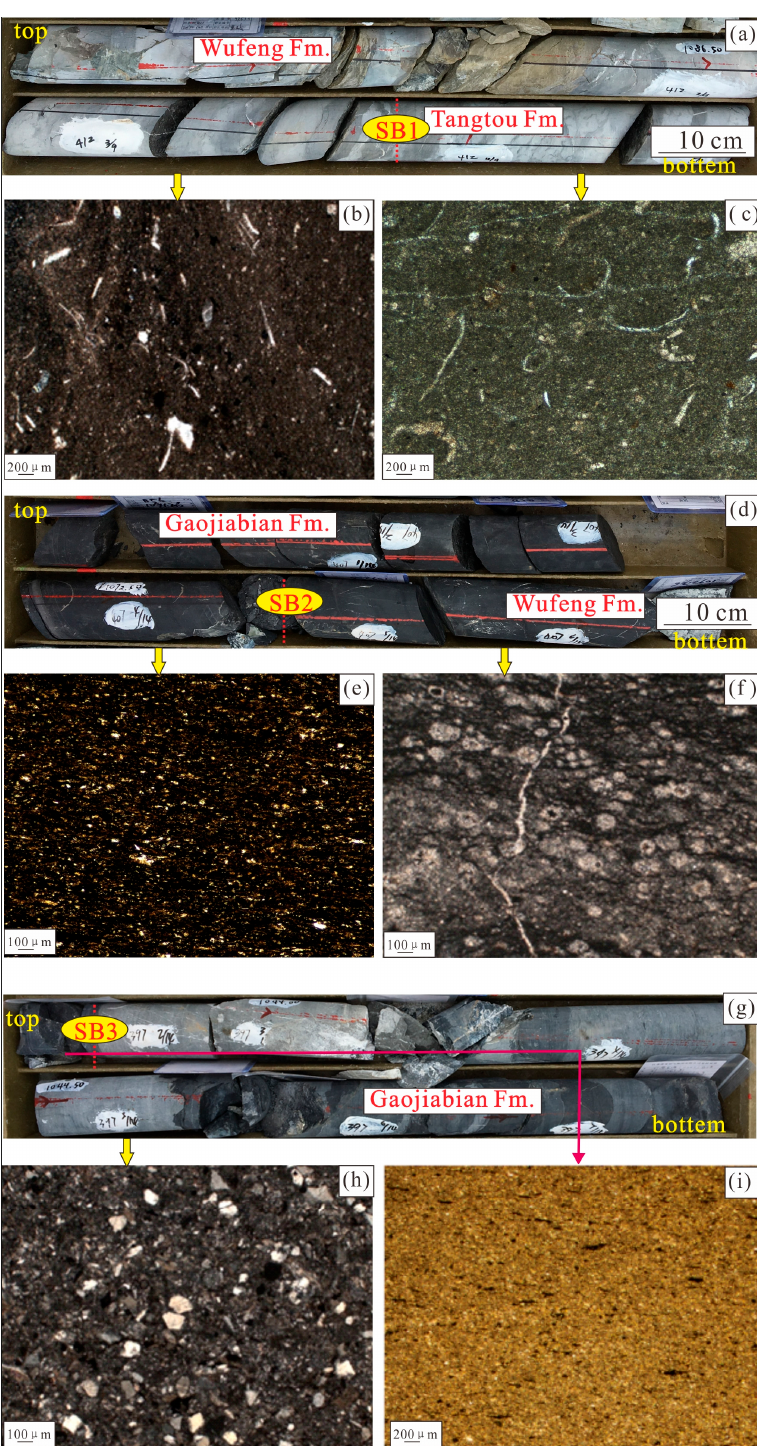
Figure 2. Sequence stratigraphic framework of the Lower Yangtze region during O/S transition based on lithology and well logs from Well SY1.